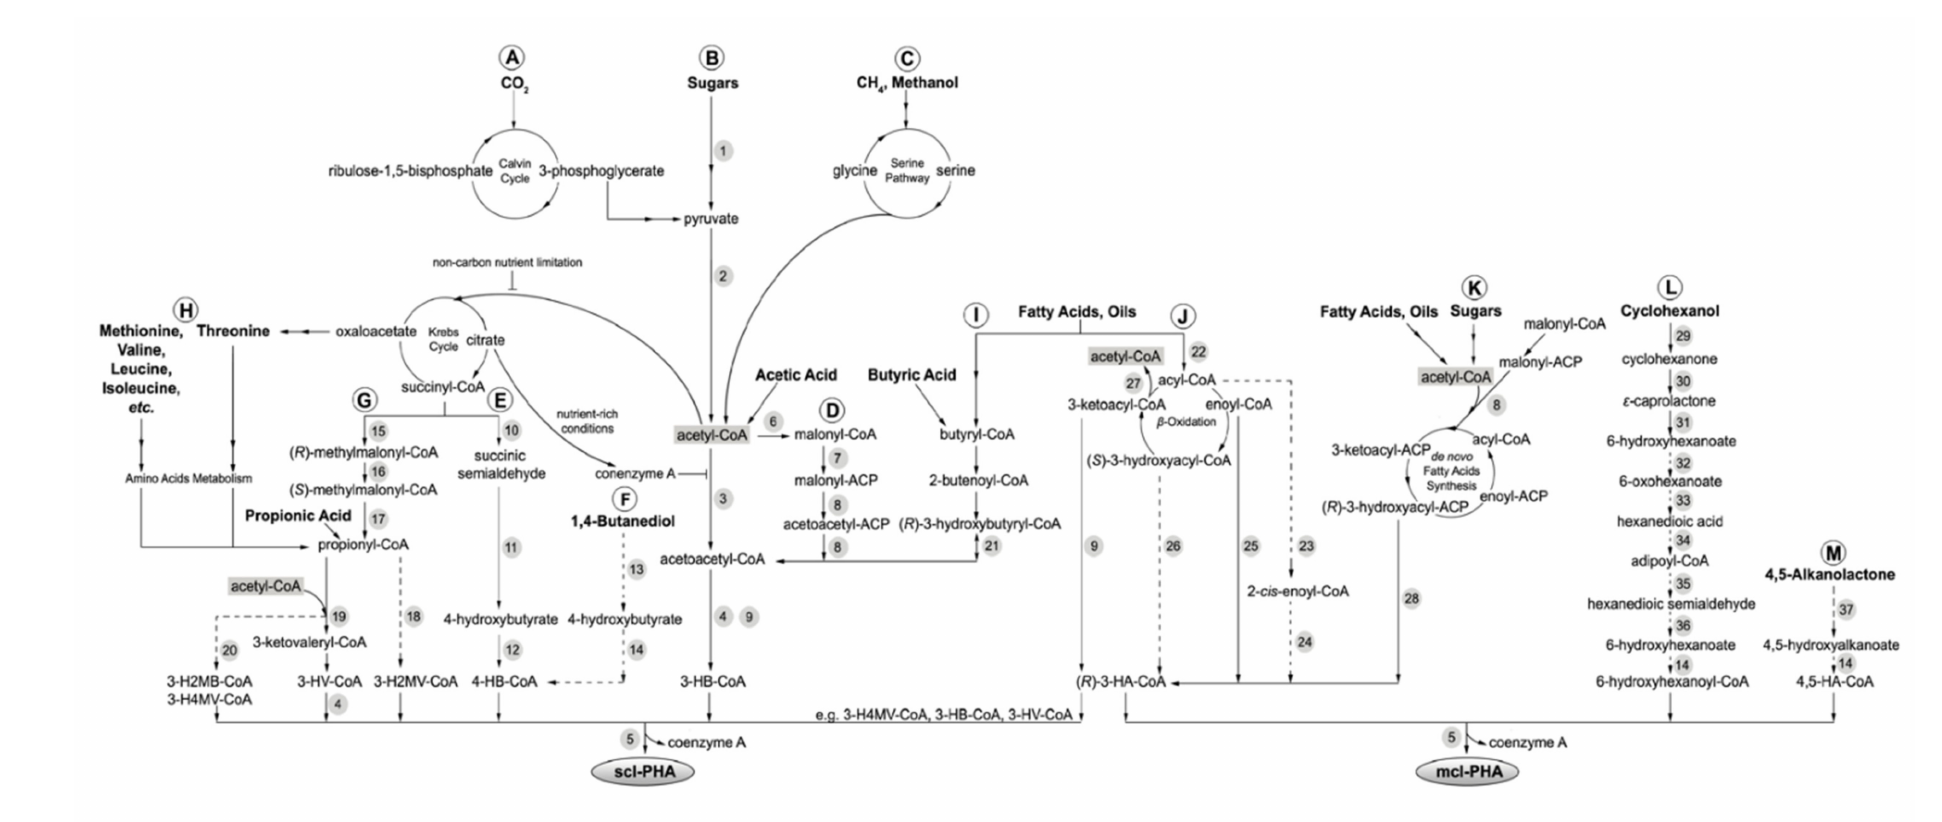
Figure 12. PHA biosynthetic pathways producing scl-PHAs and mcl-PHAs